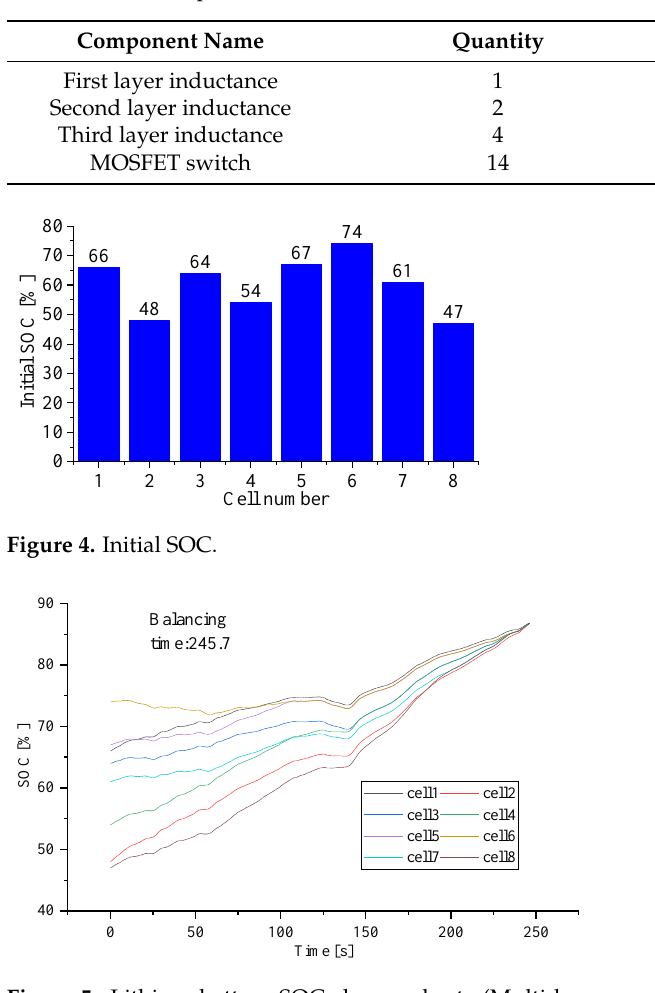
Table 4. Other components.